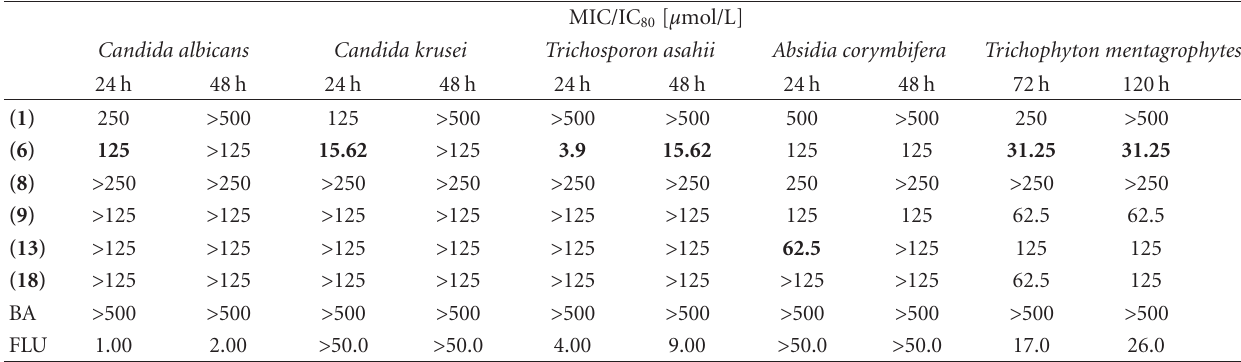
Table 2: In vitro antifungal activity of salicylanilide